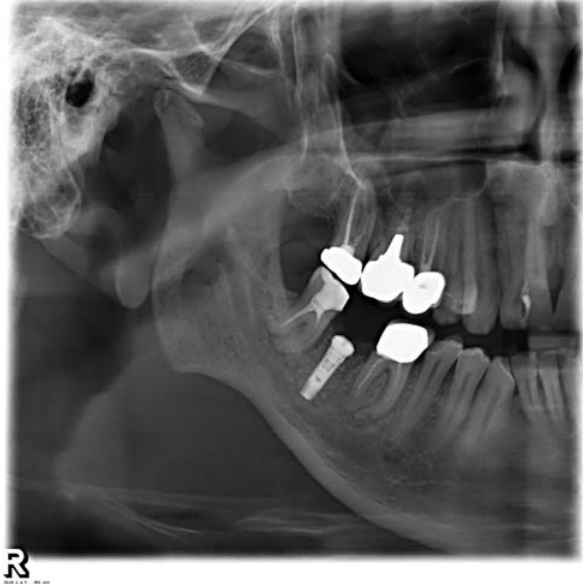
Fig. 2 Half-panoramic X-ray showing the correct endosseous implant position and perfect integration of the bone